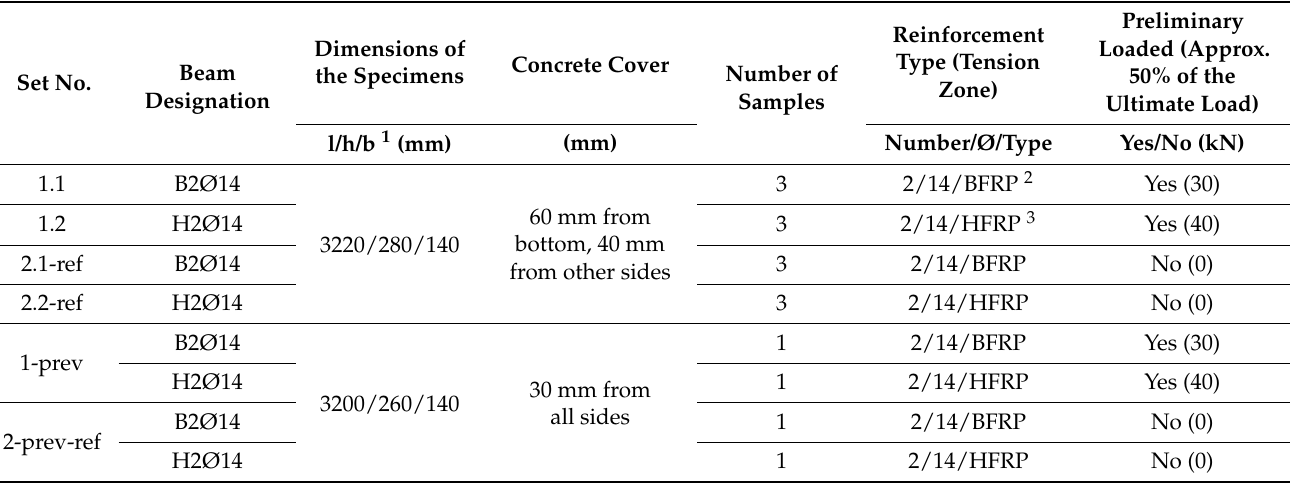
Table 2. Descriptions of specimens and loading